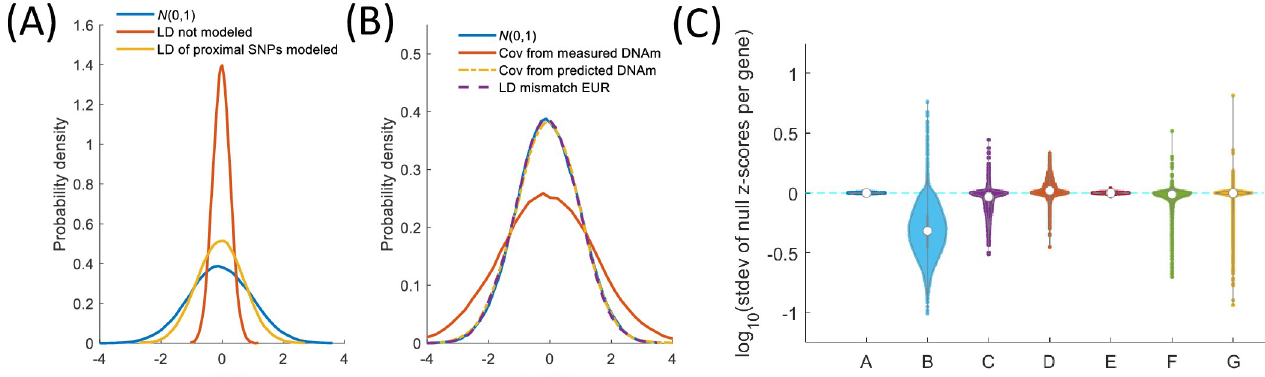
Fig 2. Calibration test. (A) Testing CEWAS requires modeling the LD structure of SNPs when generating null input z ks . Shown are probability density functions of z ig for an exemplar gene derived from 10000 sets of null z ks under different input settings. Red curve: z ks generated from N (0,1). Yellow curve: z ks generated with LD of only SNPs proximal to each CpG modeled. For both input settings, z ig are underestimated, i.e. not matching the blue curve corresponding to N (0,1). (B) By modeling LD of all SNPs proximal to CpGs of a given gene when generating null z ks and using CpG covariance based on predicted DNAm levels when estimating z i g , the resulting z i g (yellow curve) are calibrated (i.e. matching blue curve), whereas using CpG covariance based on measured DNAm levels to estimate z ig resulted in z-score inflation (red curve). In practice, the LD structure of GWAS genotype data might not match the SNP covariance of the CEWAS models. To test the effect of LD mismatch, we further used the LD structure estimated from the 1000 Genome phase 3 genotype data (European population) to generate z ks . The resulting z ig are well calibrated for this exemplar gene (purple curve). (C) Standard deviation of 10000 z ig ’s for each gene i shown across all genes. A: z ig drawn from N (0,1). B: input z ks drawn from N (0,1). C: z ks with LD of SNPs proximal to each CpG modeled. D and E: z ks with LD of all SNPs modeled and using CpG covariance based on measured and predicted DNAm levels, respectively, when estimating z ig . Standard deviation of z ig in E is ~1 for all genes, confirming that CEWAS produces calibrated z ig when LD of z ks is matched to CEWAS’s model covariance. F and G: z ks with LD estimated from 1000 Genome data, and z ig estimated by CEWAS and MetaXcan, respectively. Standard deviation of CEWAS z ig are close to or less than 1 for majority of genes except for some outliers, and the number of outlier genes is similar to MetaXcan.